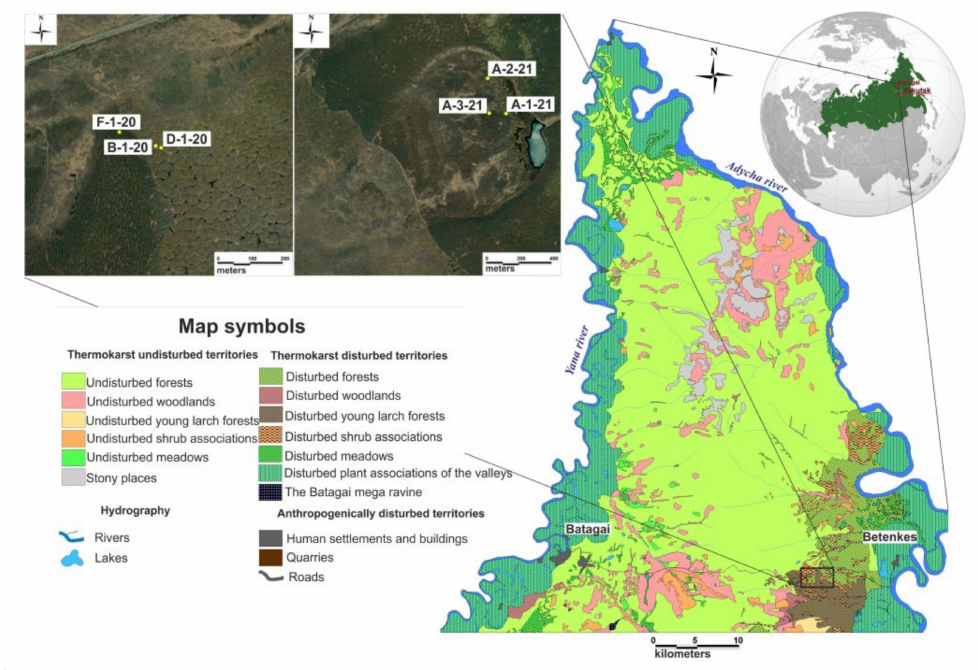
Figure 1. Location of sites on the study area Yana-Adycha